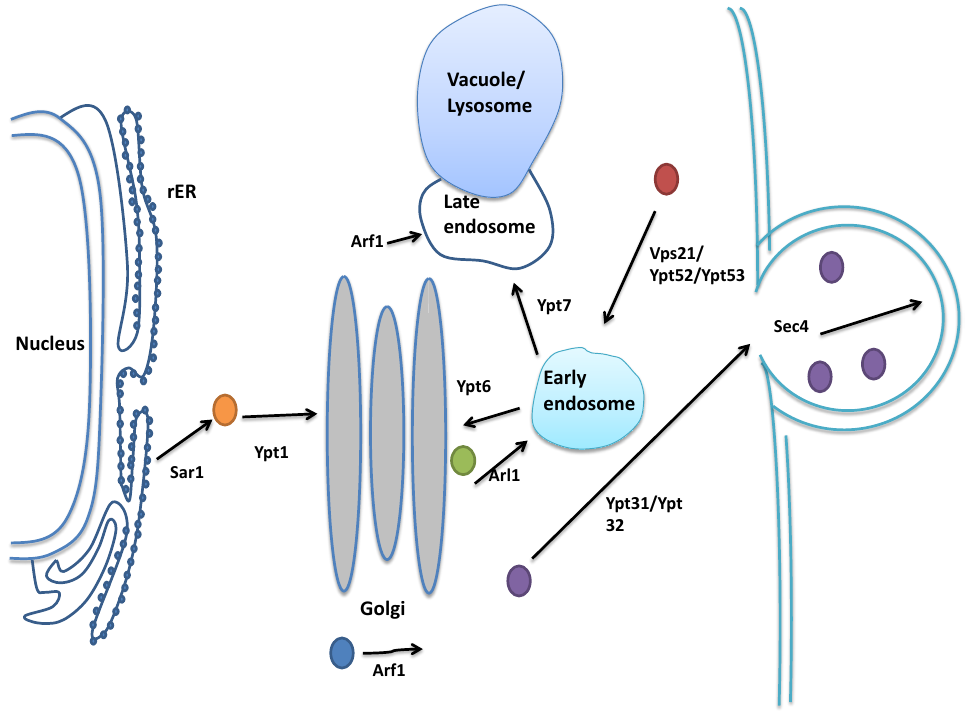
Figure 5. Monomeric GTP-binding proteins in vesicle trafficking in